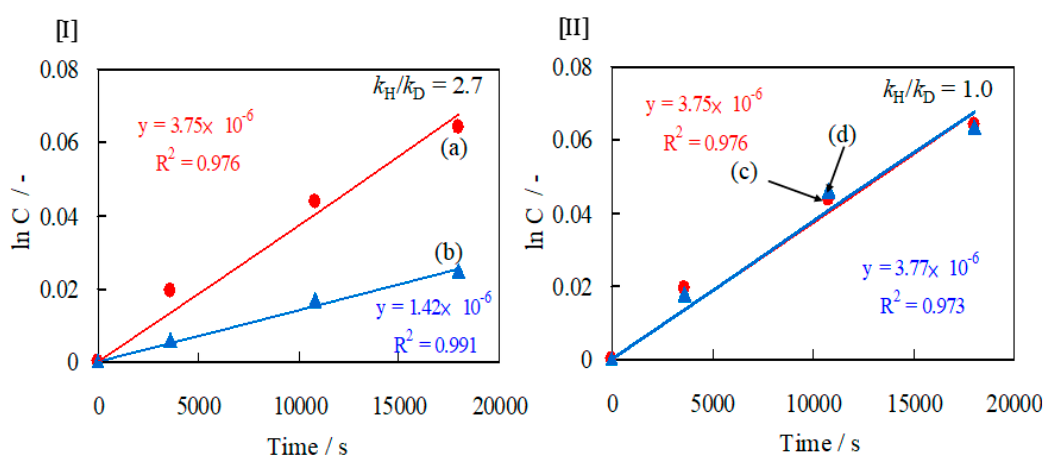
Figure 4. Kinetic isotope e ff ects (KIE) on photocatalytic hydroxylation of benzene in the presence of air and H 2 O on Pt(0.2)-WO 3 (20 mg) under visible light irradiation. Hydroxylation of C 6 H 6 in the presence of H 2 O (a) and D 2 O (b) [ I ]; and that of C 6 H 6 (c) and C 6 D 6 (d) in the presence of H 2 O [ II ].